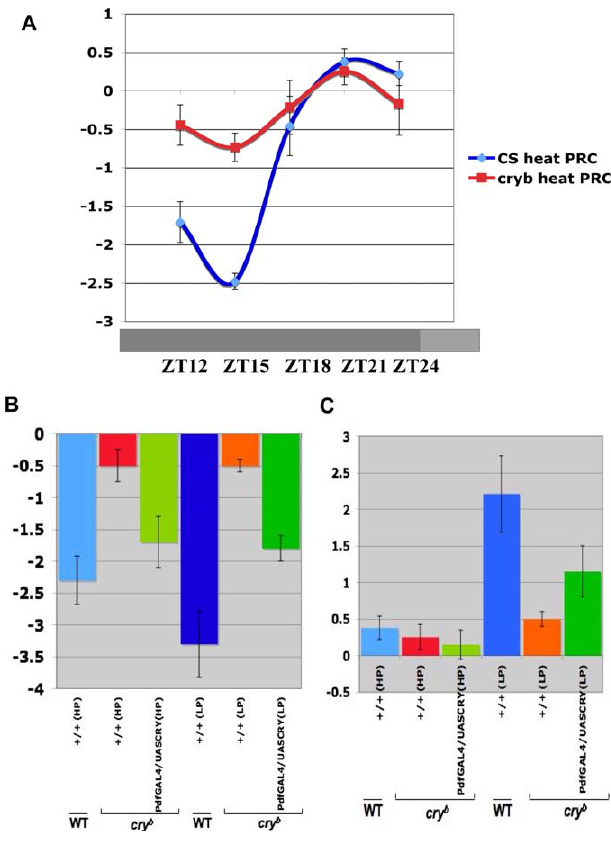
Figure 3. 37 8 C Heat Pulse–Mediated Phase Responses of cry b and Rescued Strains (A) Phase response curves for wild-type (circle) flies and cry b (square) mutant flies. The experiment was performed as described in Figure 1. Phase delays and phase advances are plotted ( 6 SEM) as negative and positive values, respectively. Data were pooled from the following number of flies (each pair of values referring to wild-type heat pulsed and cry b heat pulsed): control: 32, 32; pulse at ZT12: 22, 39; pulse at ZT15: 26, 40; pulse at ZT18: 26, 39; pulse at ZT21: 19, 36; and pulse at ZT24: 27, 15. (B and C). Bottom left and right panels show the phase changes observed at ZT15 (B) and ZT21(C), respectively. On the x -axis, the Zeitgeber 37 8 C heat (HP) or light pulse (LP) is indicated. Phase delays and advances are described in Figure 1 and plotted on the y- axis ( 6 SEM) as negative and positive values, respectively. The genotype of the flies is indicated on the x -axes: the first row shows the transgenes present (plus sign corresponds to a chromosome without a transgene), whereas the second row indicates the genetic background (wild-type [WT] or cry b